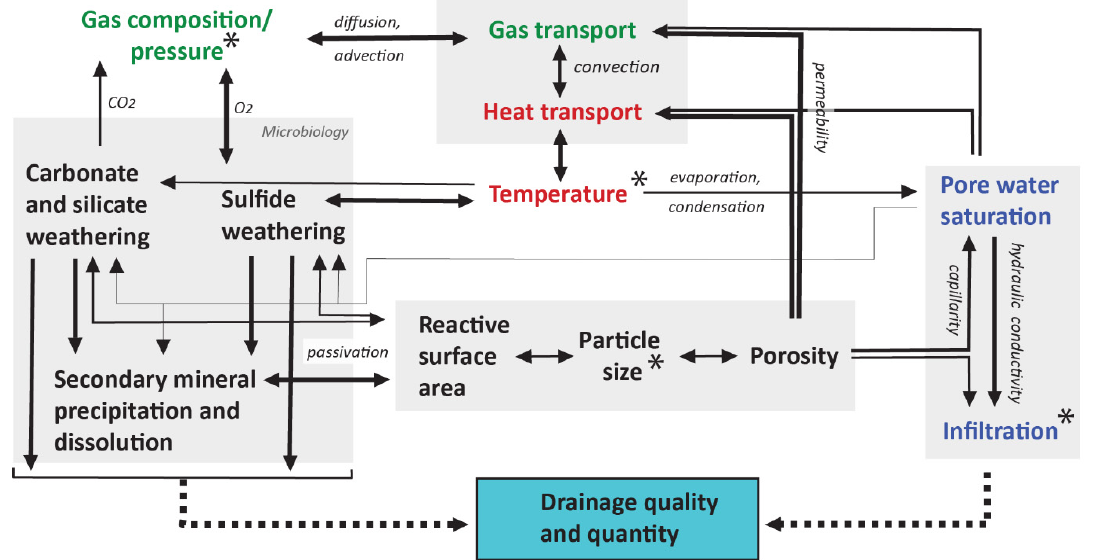
Figure 4. Schematic illustration of major couplings and feedbacks between geochemical reactions and physical transport processes. Solid arrow lines indicate interactions or a control-hierarchy between different processes, with the width of the arrow being (qualitatively) proportional to the magnitude or strength of the feedback. External controls include that of site meteorology on infiltration, temperature, and gas pressure and that of site geology and communition method on waste-rock particle sizes, as indicated by the asterisks.